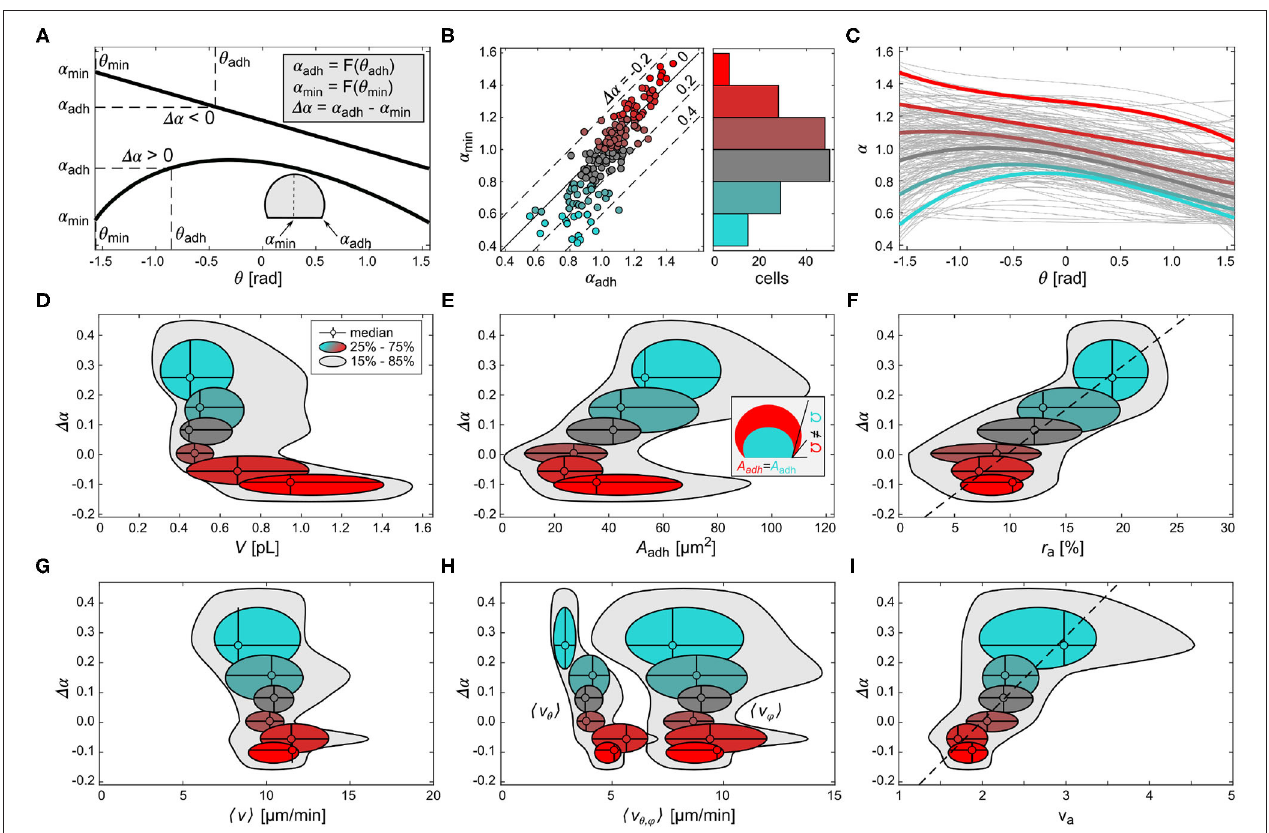
FIGURE 4 | Comparison of fluctuation, geometry and domain dynamics between cells. (A) Scheme of two different weighted polynomial fits of α -histogram showing the minimal latitude ( θ min ) and contact perimeter ( θ adh ), and the respective levels of α ( α min , α adh ) that define the difference 1α . (B) The left panel shows the relation between α min and α adh . The color scheme is applied as a function of α min . The right panel shows the number of cells that correspond to each α min level, as a histogram. (C) The weighted polynomial fits of all cells (gray lines) and averaged representative fits of the binned α min levels shown in the respective color. (D–I) The difference of α , 1α plotted as a function of the cell volume V in (D) , the ventral membrane area A adh in (E) , the ratio between ventral and entire membrane area A adh / A mem in (F) , the mean domain speed r a v in (G) , average vertical v θ and horizontal v φ wave speed in (H) , and the domain speed ratio v a v ϕ / v θ (I) . The = h i h i h i = color scheme corresponds to the α min levels shown in (B) . The dashed lines in (F,I) are the linear fits of the medians. The inset in (E) depicts the difference in membrane curvature, representatively shown by the contact angle (cid:127) , for two cells of different volume but equal ventral area A adh